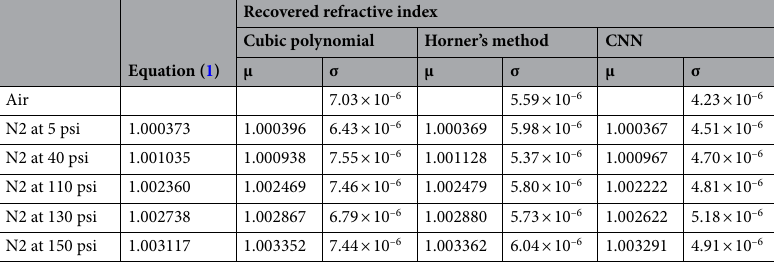
Table 3. Mean and standard deviation values of different refractive indices from three